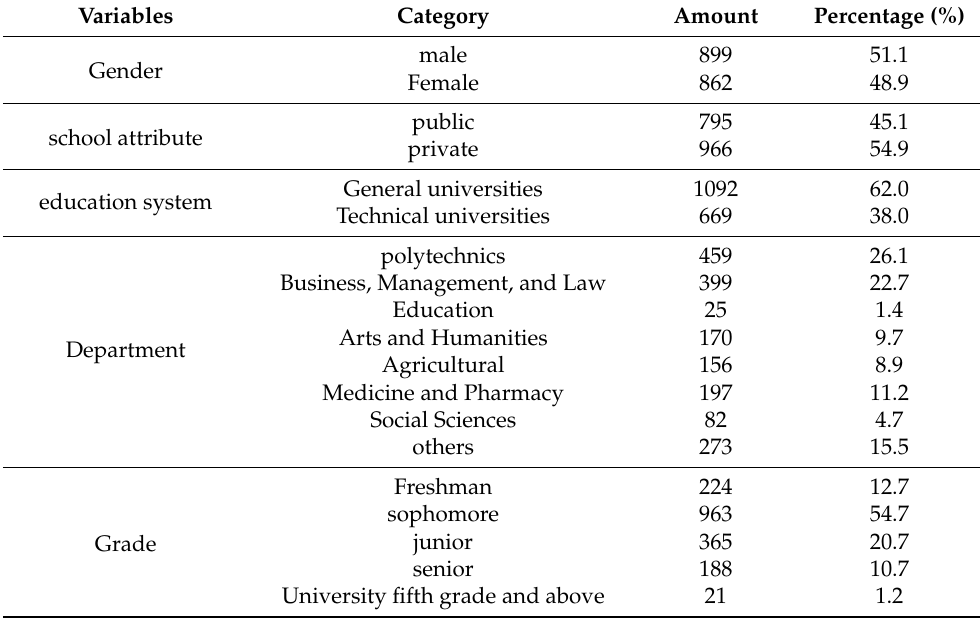
Table 3. Summary of Personal Background Information